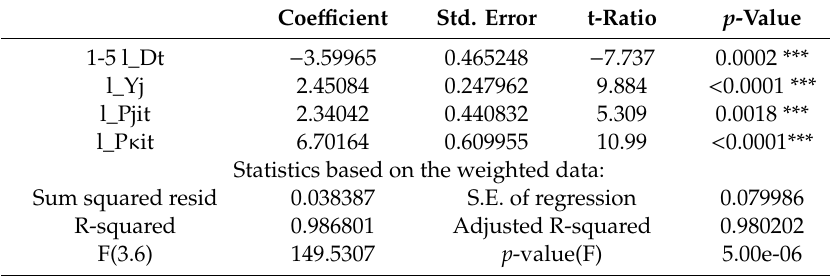
Table 13. FGLS estimation of Hungarian tourist consumption in Croatia – final model. Model 4: FGLS, using observations 2009–2018 (T = 10); dependent variable: l_TXji; variable used as weight: